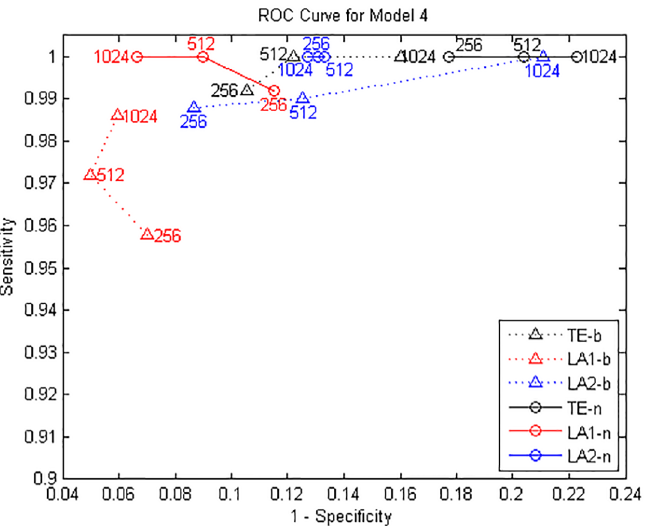
Fig 8. ROC curves for Model D. TE-b/LA1-b/LA2-b are the results by binning entropy estimator and TE-n/LA1-n/ LA2-n by NN entropy estimator, sensitivity and specificity are obtained by gradually increasing the time series length from 256 to 1024